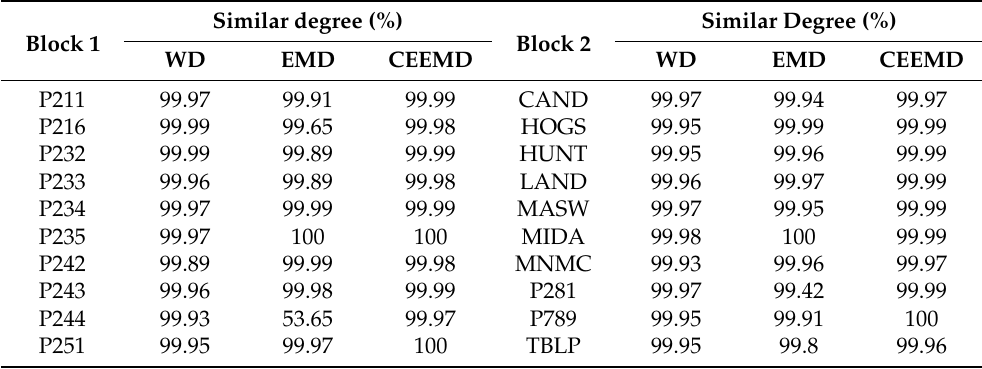
Table 4. Similarity between denoised GNSS time series and trend term obtained via WD, EMD and CEEMD, separately.